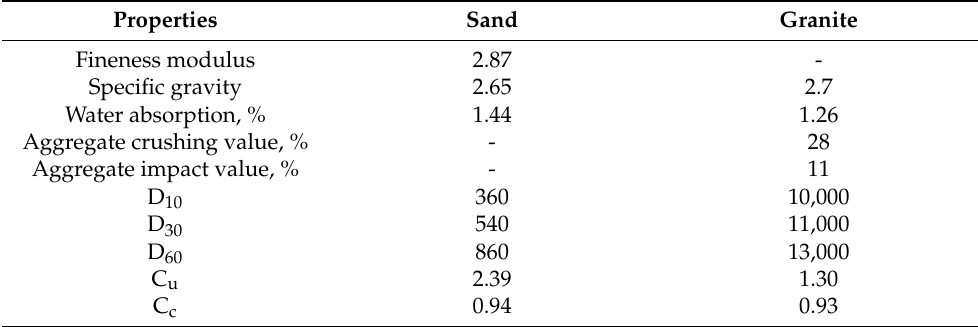
Table 2. Physical and mechanical properties of aggregates.